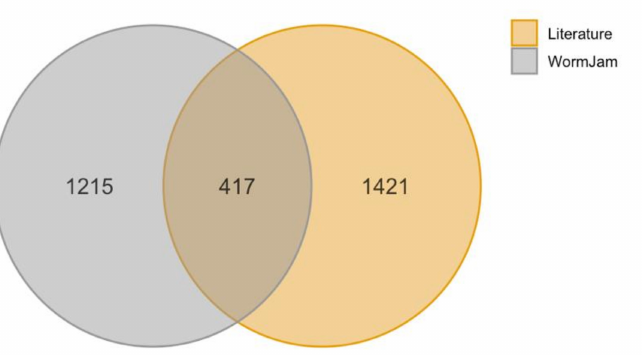
Figure 3. Venn diagram of overlap of metabolites between literature (yellow) and WormJam (grey) based on the first block of their